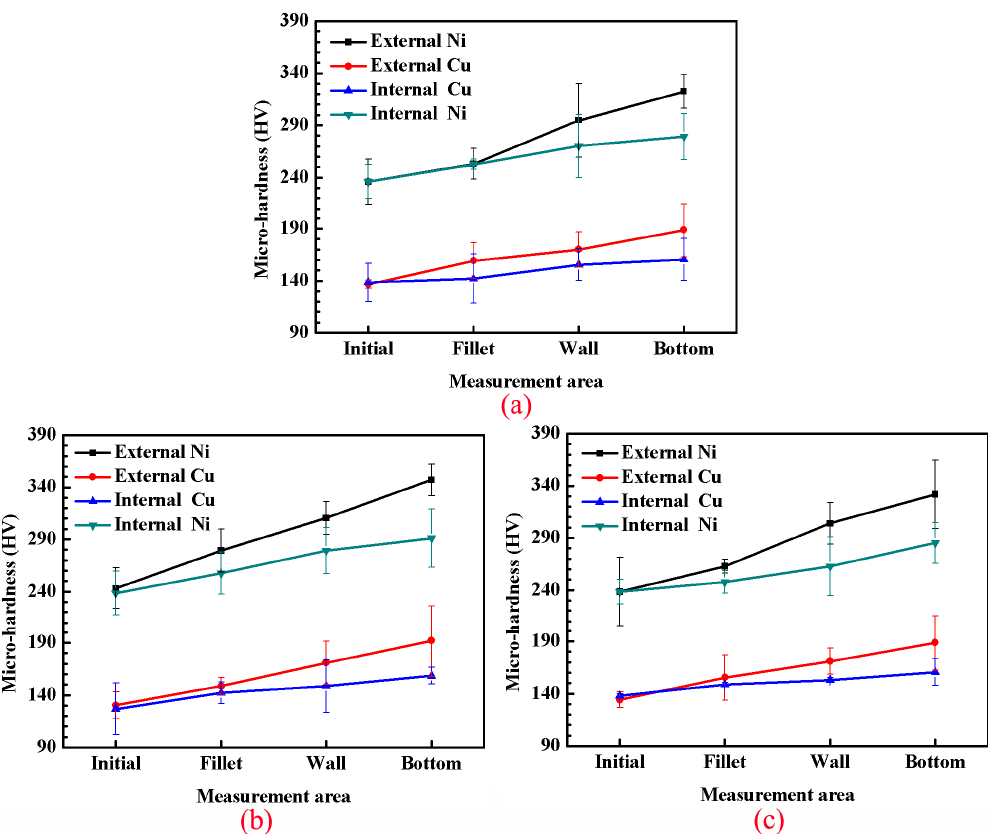
Figure 15. Micro-hardness distribution of different feature size: ( a ) mold 1; ( b ) mold 3; ( c ) mold 5.